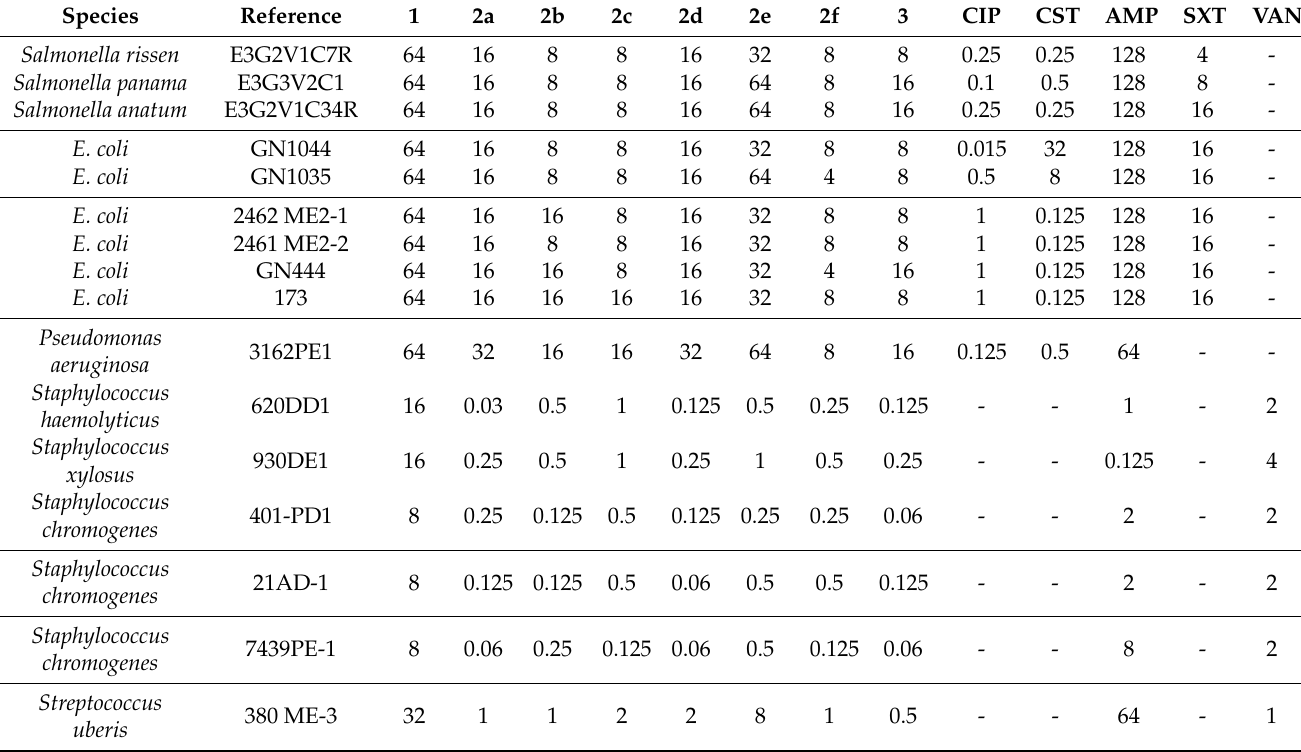
Table 1. Summary of the MIC values (mg/L) of the (CˆS)-cyclometallated Au(III) complexes and standard drugs under investigation.